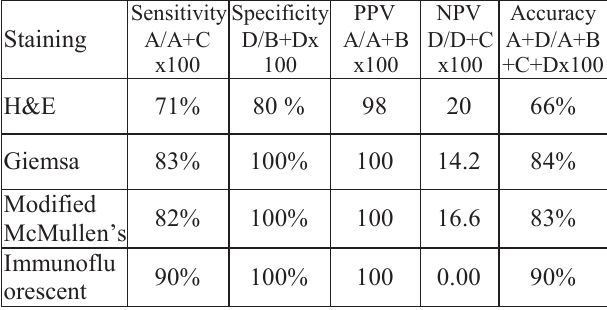
Table-3: Statistical analysis